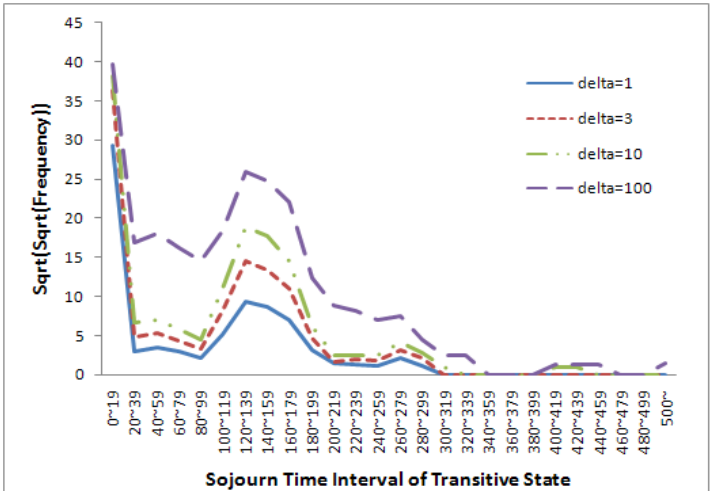
Figure 10. Example of frequency graph for different δ